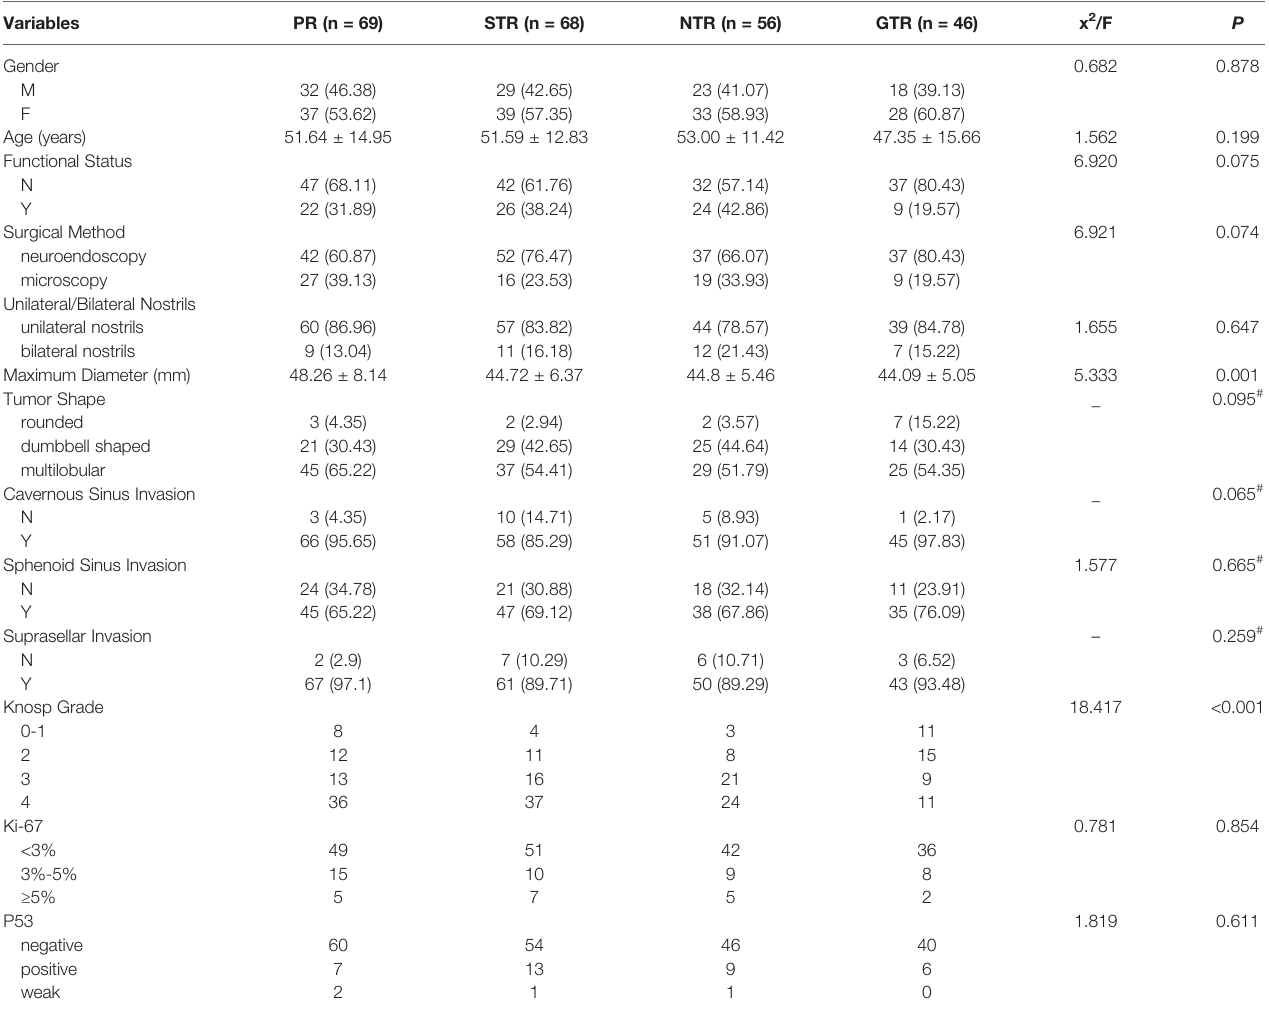
TABLE 7 | The effect of various tumor characteristics on the extent of resection.